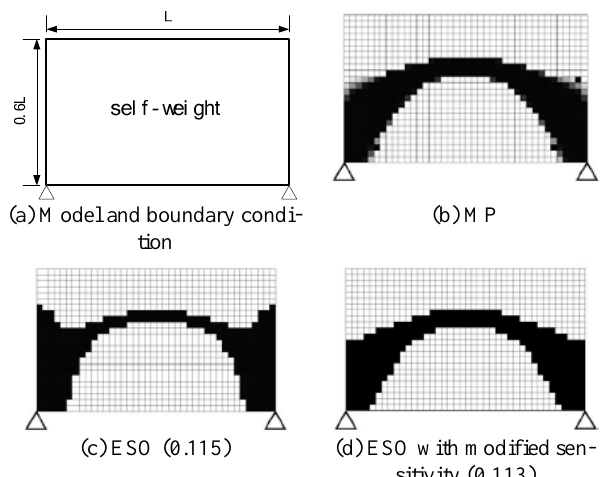
Fig. 2 Optimal results of arch structure under self-weight load (Ansola et al.